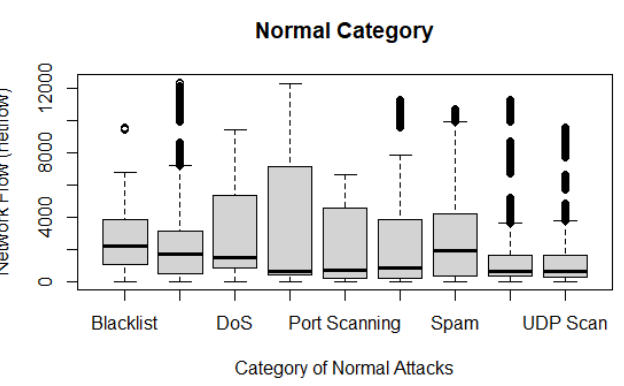
Figure 25. The proportion of normal malware in the UGRansome dataset.